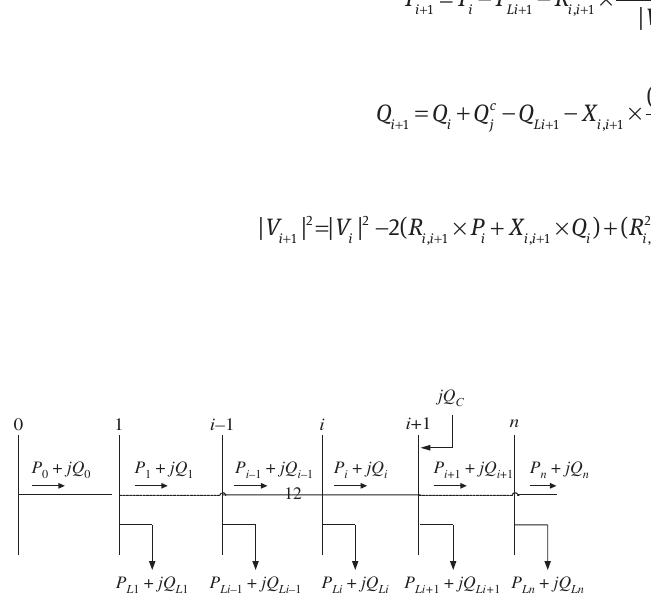
Figure 1: Equivalent Branch of an Electrical Distribution